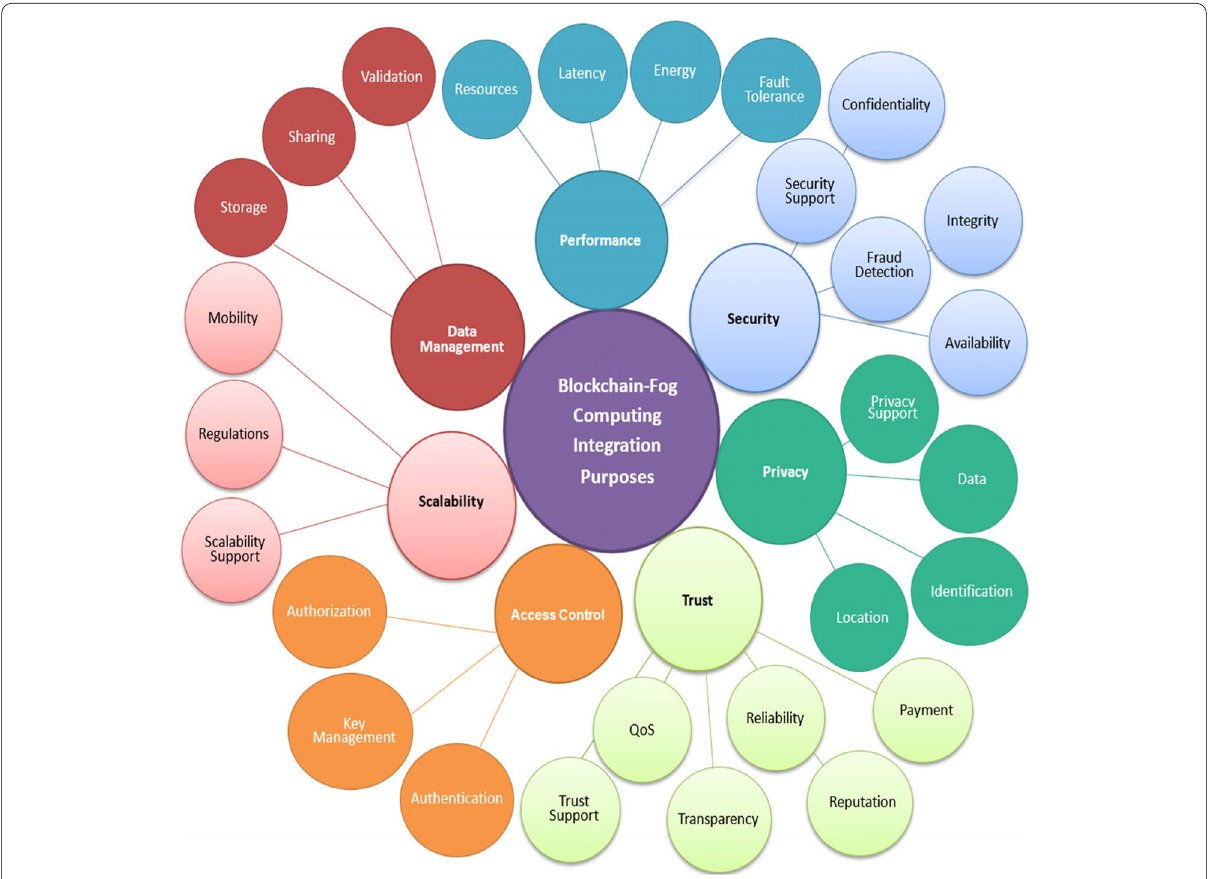
Fig. 5 BC with FC integration